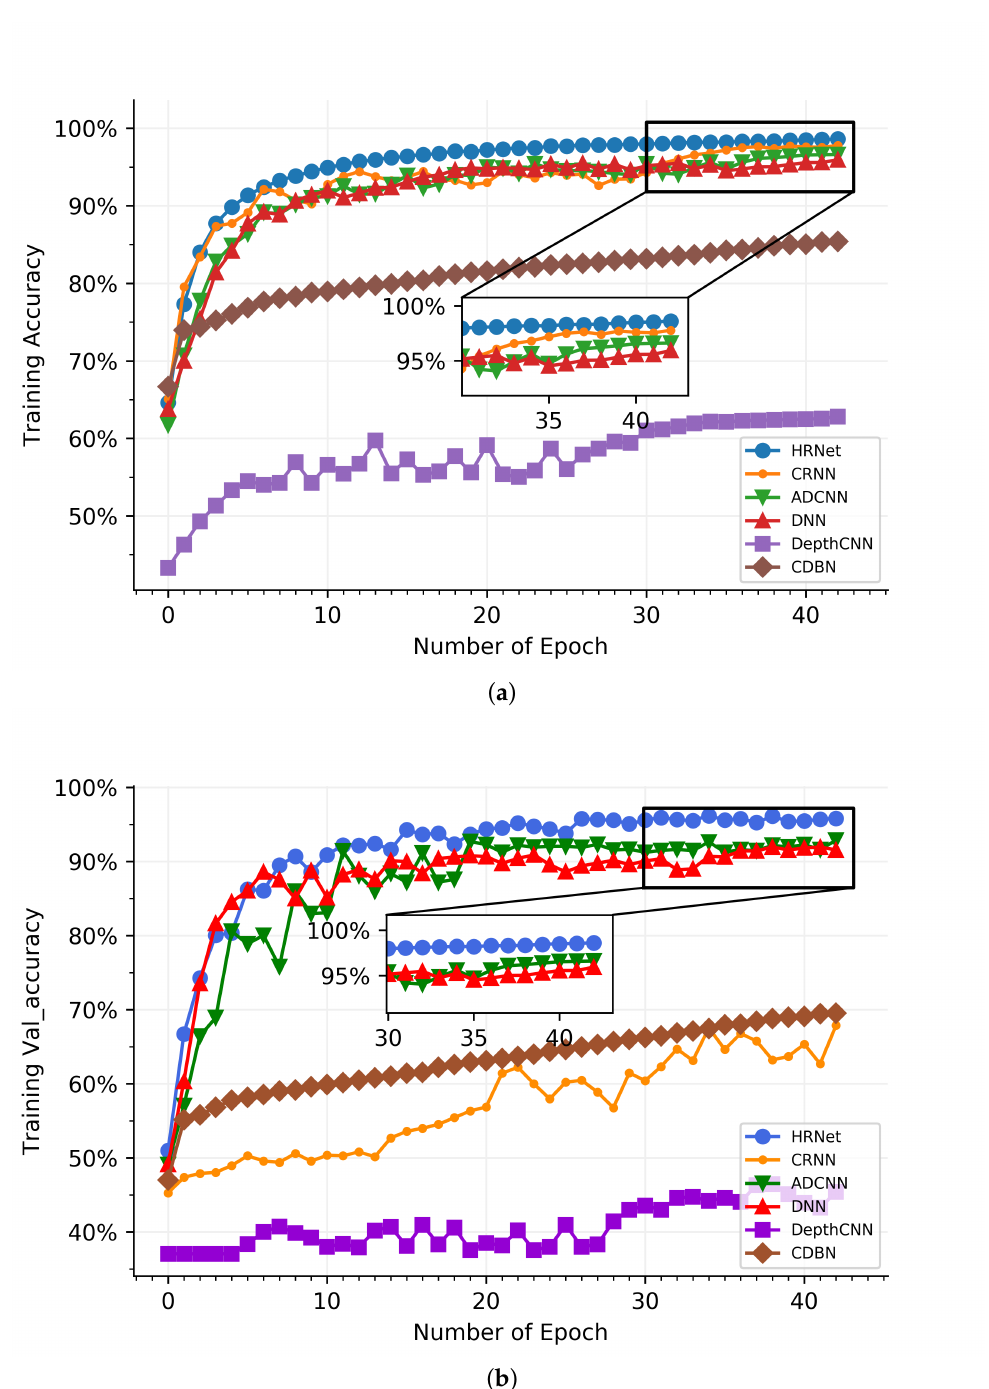
Figure 9. Classification results between different networks. ( a ) Training accuracy. ( b ) Validating